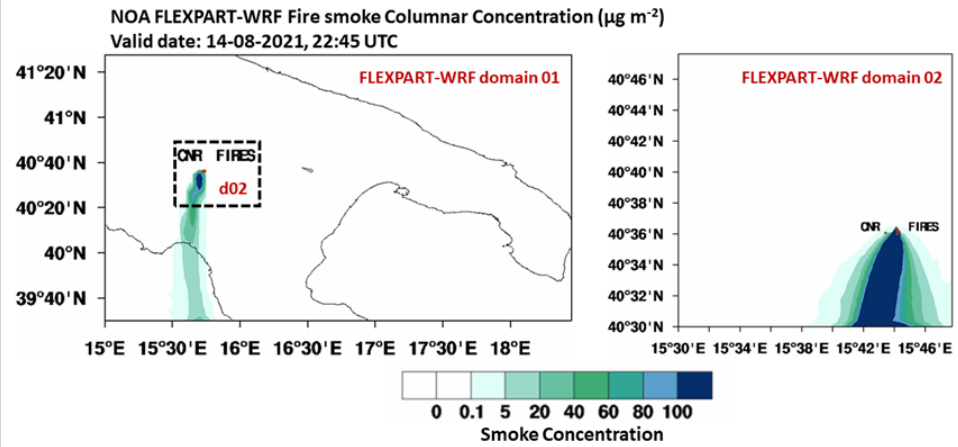
Figure 2. Simulated FLEXPART– − WRF columnar concentration ( µ g m − 2 ) in two modeling domains for the smoke episode on 14 August 2021, 22:45 UTC: ( left panel ) 3° × 3° (300 km), and ( right panel ) 0.1° × 0.1° (11 km) horizontal resolution.